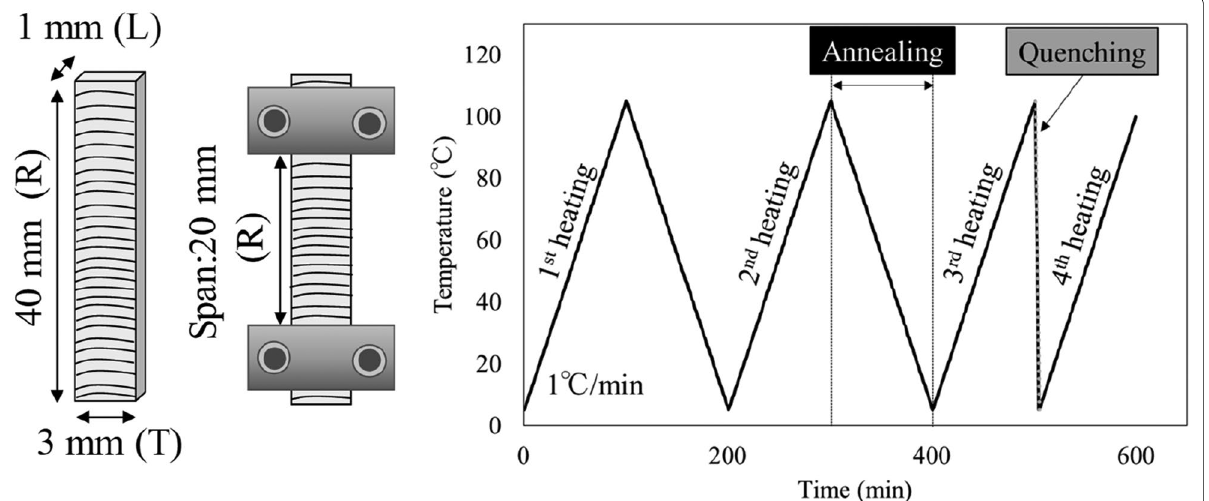
Fig. 1 Schematic diagram of the sample attached to the forced‑vibration dynamic viscoelastometer and temperature program for measurement of temperature